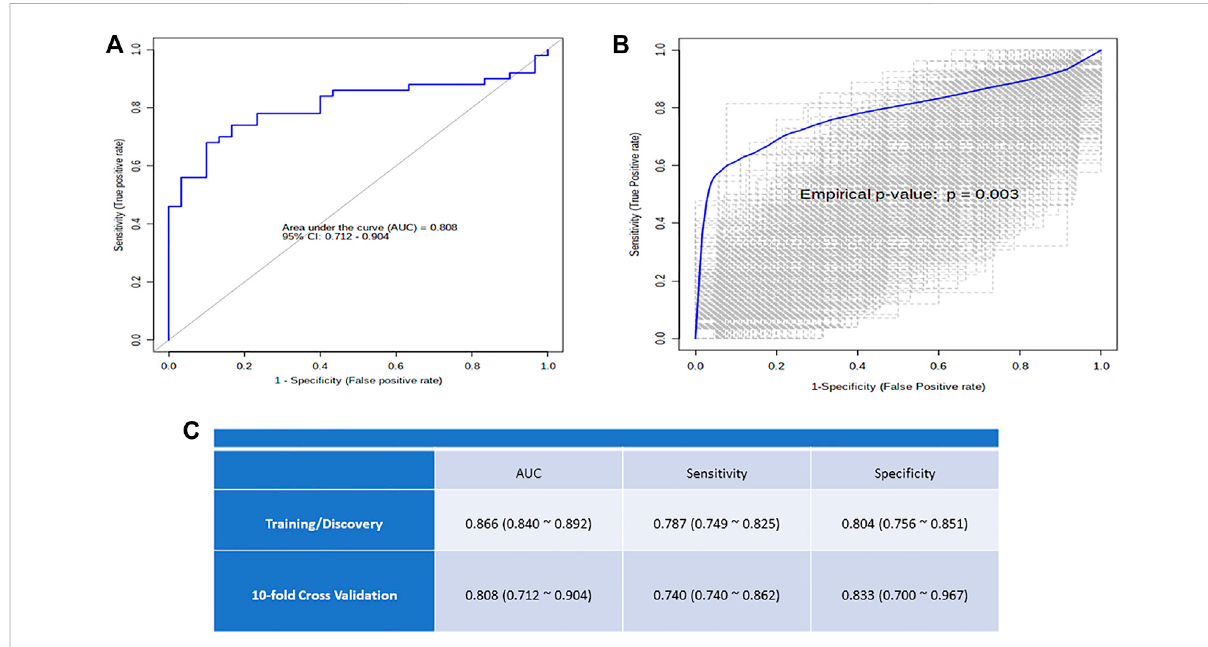
FIGURE 6 (A) The logistic regression ROC analysis for controls versus OSA and distribution of metabolite concentration used for model building; (B) Box plot of the predictive accuracy of the created biomarker model; (C) The plot shows the AUC of all permutations, highlighting the actual observed AUC in blue, along with showing the empirical